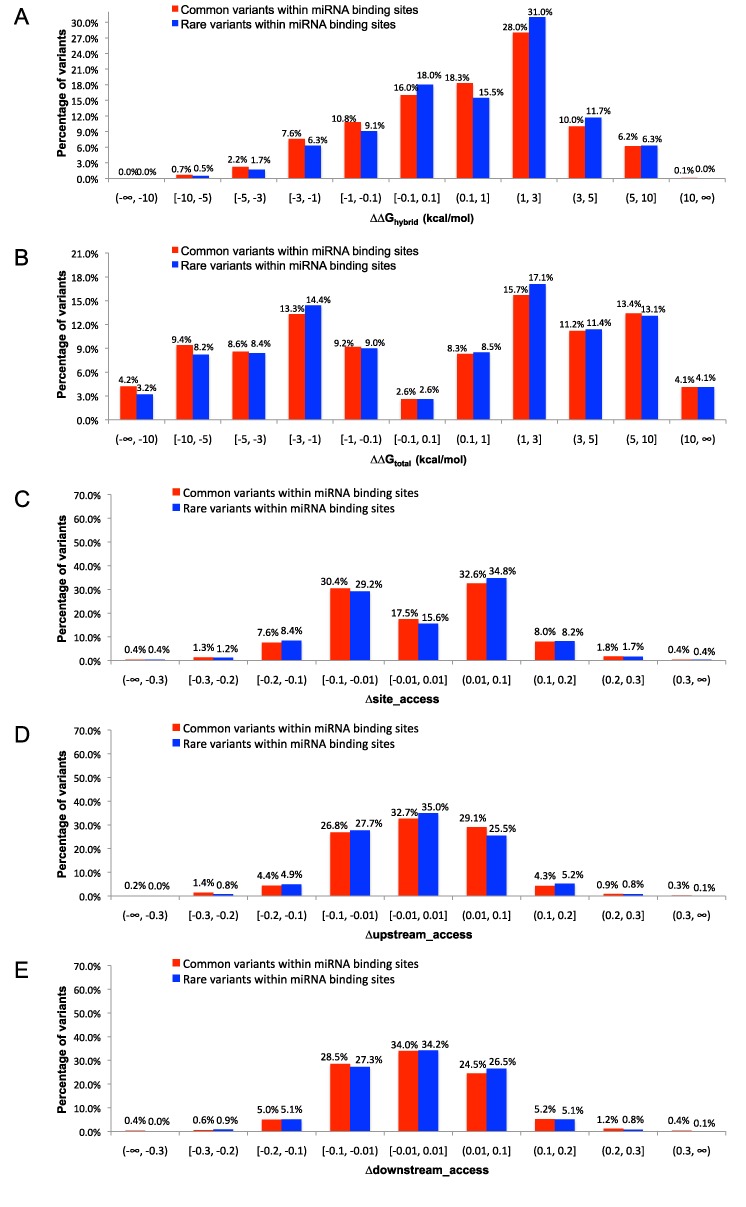
The histograms of effect measures for common (MAF ≥1%) and rare (MAF <1%) variants in miRNA binding sites (the horizontal axis intervals (a,b], [a,b), (a,b), [a,b] are defined by a<x≤b, a≤x<b, a<x<b, a≤x≤b, respectively, where x is the value of the feature). (A) ΔΔGhybrid; (B) ΔΔGtotal; (C) Δsite_access; (D) Δupstream_access; (E) Δdownstream_access.